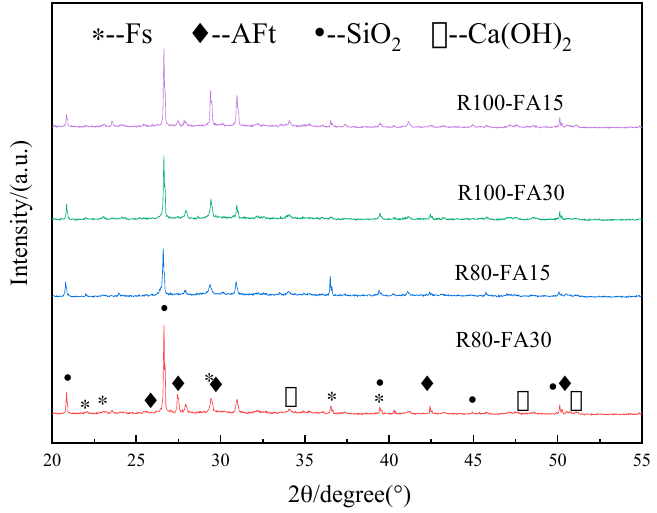
Figure 13. XRD patterns of specimens exposed to 3%NS-45FT.